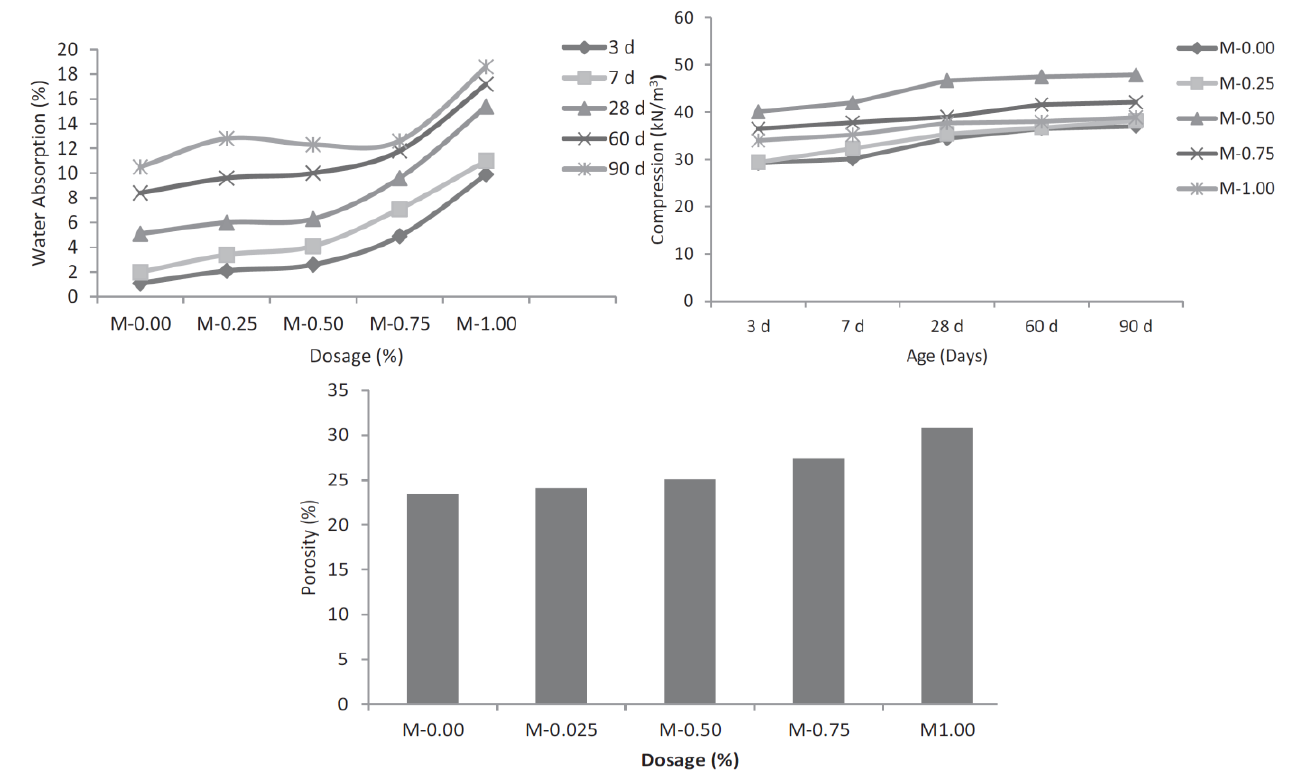
Figure 13. Test results gum Arabic effecting on concrete properties (Elinwa et al.